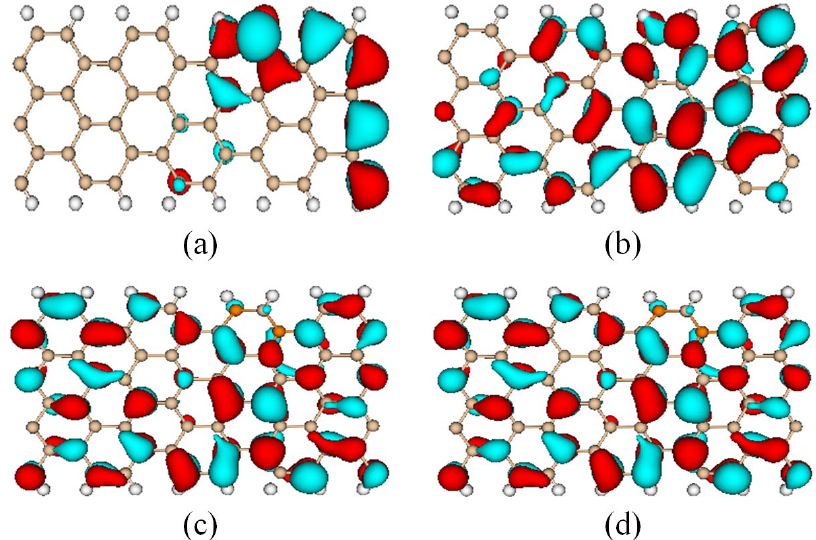
Figure 7. ( a ) MPSH of A6-E at an eigenvalue of E v = −0.21 eV at a bias of 0.5 V; ( b ) MPSH of A7-E at an eigenvalue of E v = 0.15 eV at a bias of 0.5 V; ( c , d ) MPSH of A8-E at an eigenvalue of E v = −0.07 eV at a bias of 0.5 V and −0.5 V, respectively. at a bias of 0.5 V and − 0.5 V,